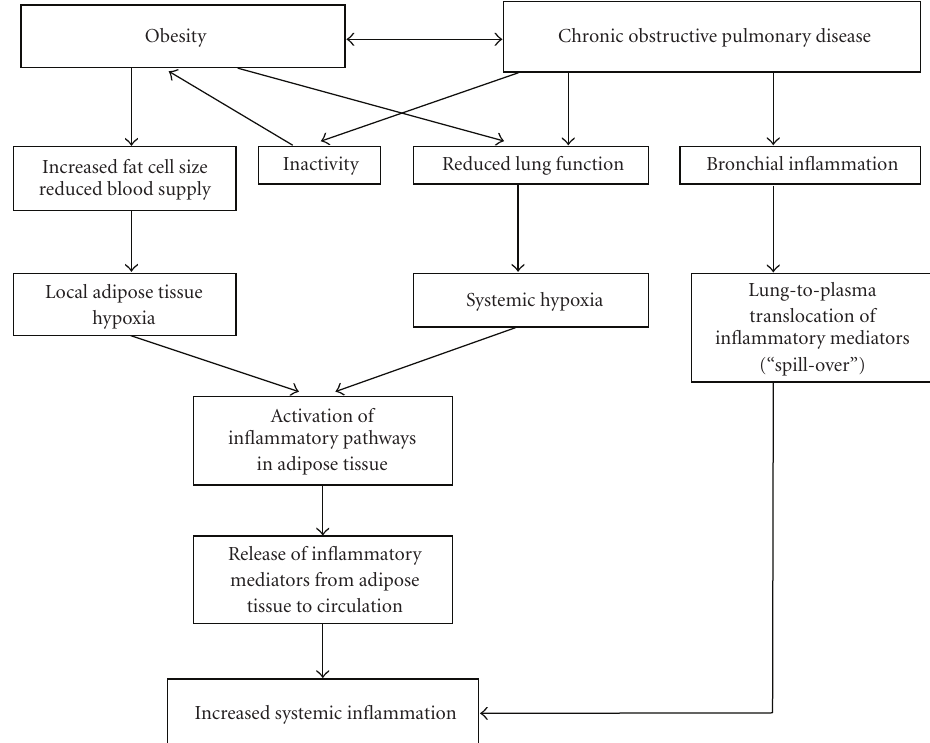
Figure 2: Proposed mechanistic links between the combined e ff ects of obesity-related local adipose tissue hypoxia, reduced lung function- related systemic hypoxia, and bronchial inflammation-related increased lung-to-plasma translocation of inflammatory mediators on systemic inflammatory profile in patients with